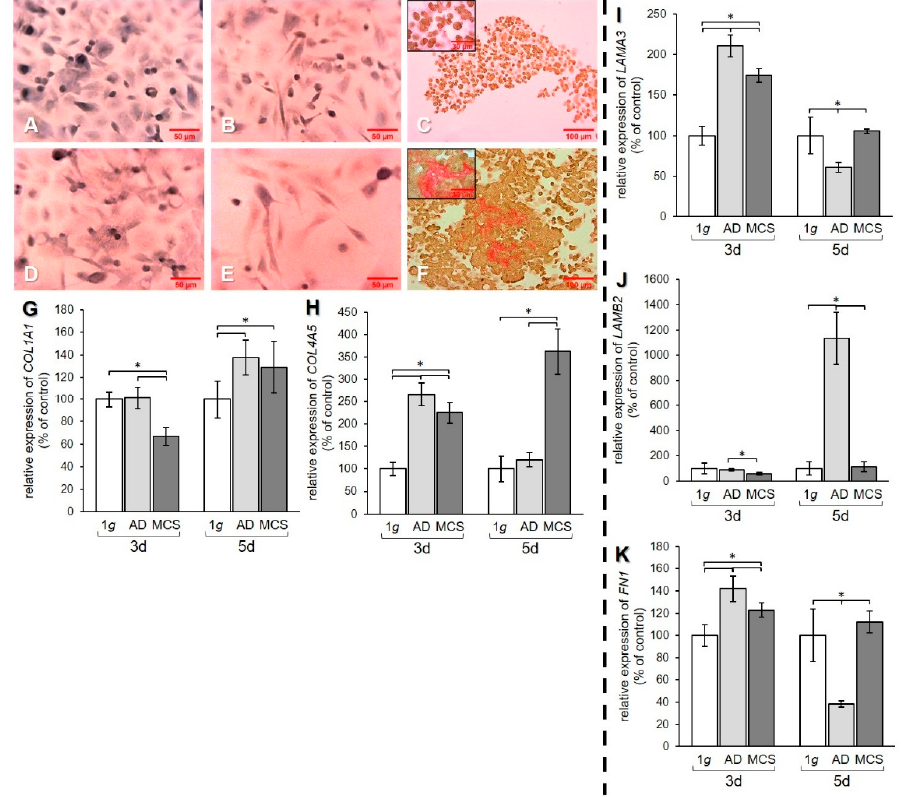
Figure 4. Investigation of ECM components. Collagen deposition in PC-3 cells stained with Sirius red (SR) after ( A – C ) 3 days and ( D – F ) 5 days. 1 g control cells ( A , D ) AD ( B , E ) and MCS ( C , F ). Depositions of collagen I and III are stained in red. qPCR results show relative mRNA transcription levels of ( G ) COL1A1 , ( H ) COL4A5 , ( I ) LAMA3 , ( J ) LAMB2 , and ( K ) FN1 genes in 3-day and 5-day AD and MCS. * p <